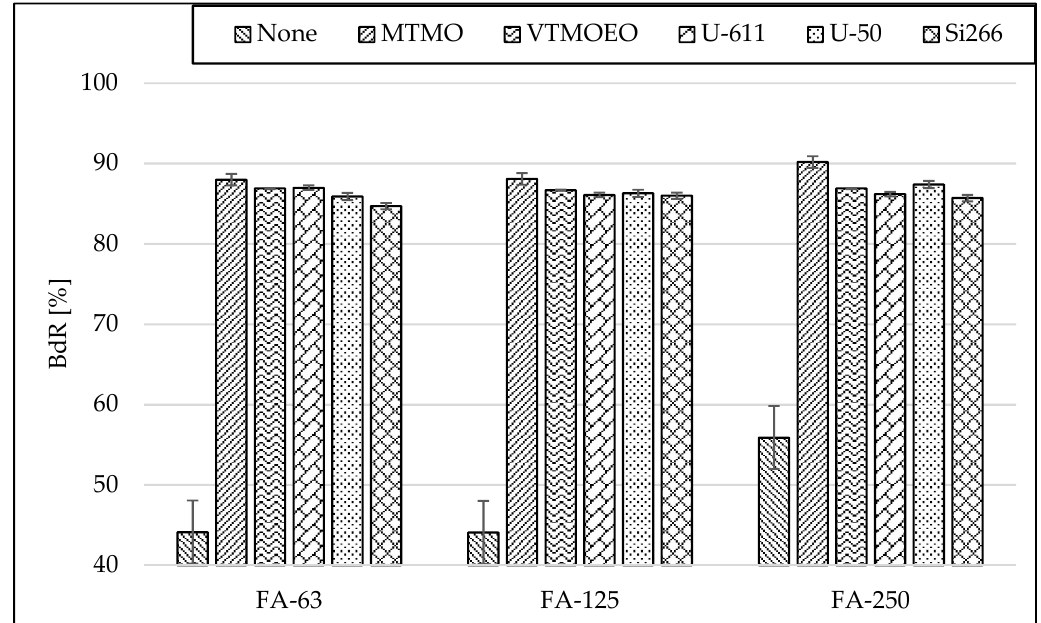
Figure 6. Influence of silanization on the Bound Rubber content (BdR) in rubber vulcanizates containing 30 phr of N 220 and 20 phr of fractionated fly ash.